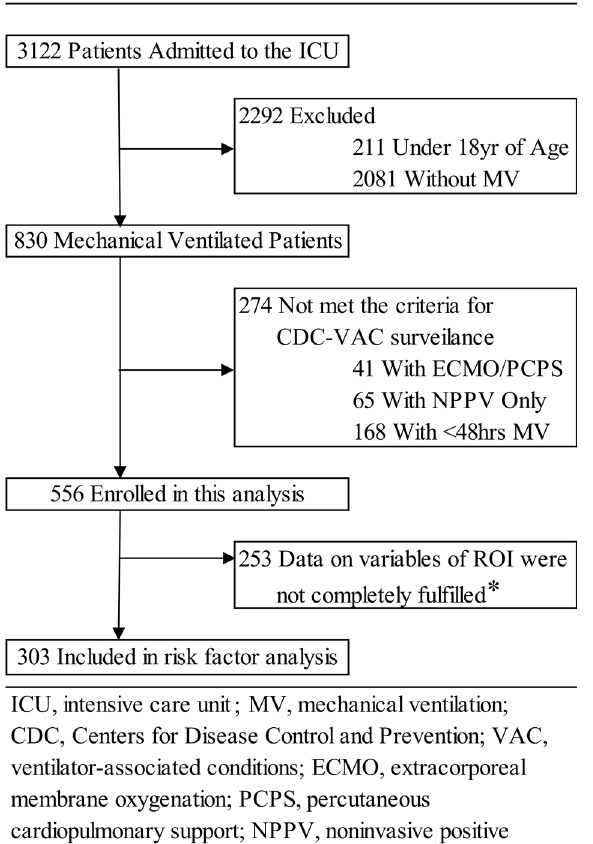
Fig 1. Patient disposition chart. CDC, Centers for Disease Control and Prevention; ECMO, extracorporeal membrane oxygenation; ICU, intensive-care unit; MV, mechanical ventilation; PCPS, percutaneous cardiopulmonary support; NPPV, noninvasive positive pressure ventilation; VAC, ventilator-associated